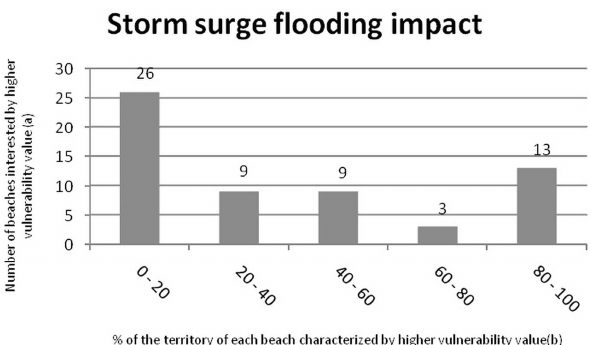
Fig. 8. Vulnerability of beaches to the storm surge flooding impact: number of beaches affected by higher vulnerability values in the case study area (a) , according to the percentage of the territory of each beach characterized by higher vulnerability values (b)